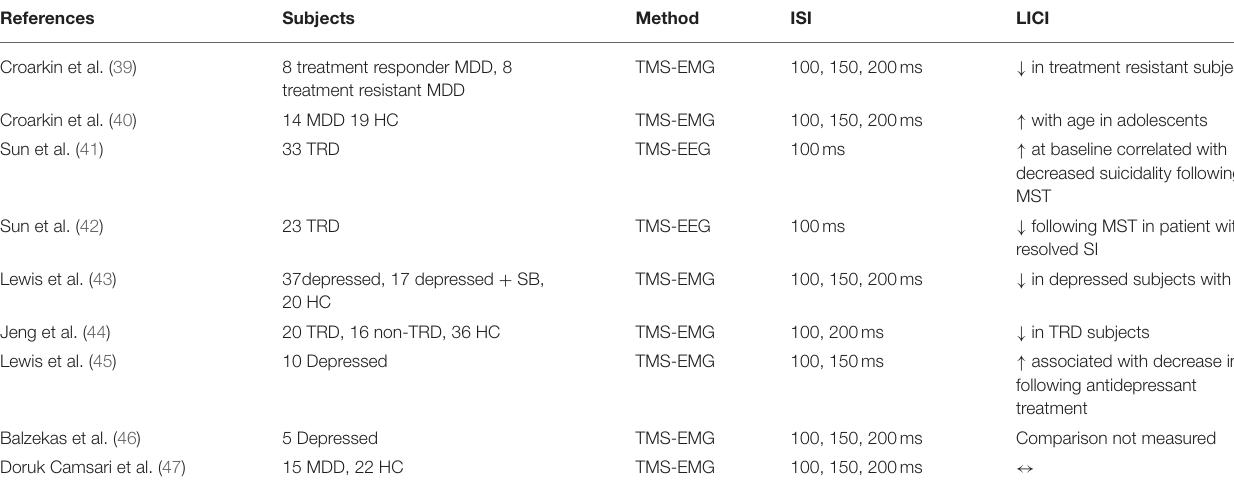
TABLE 3 | LICI in patients with